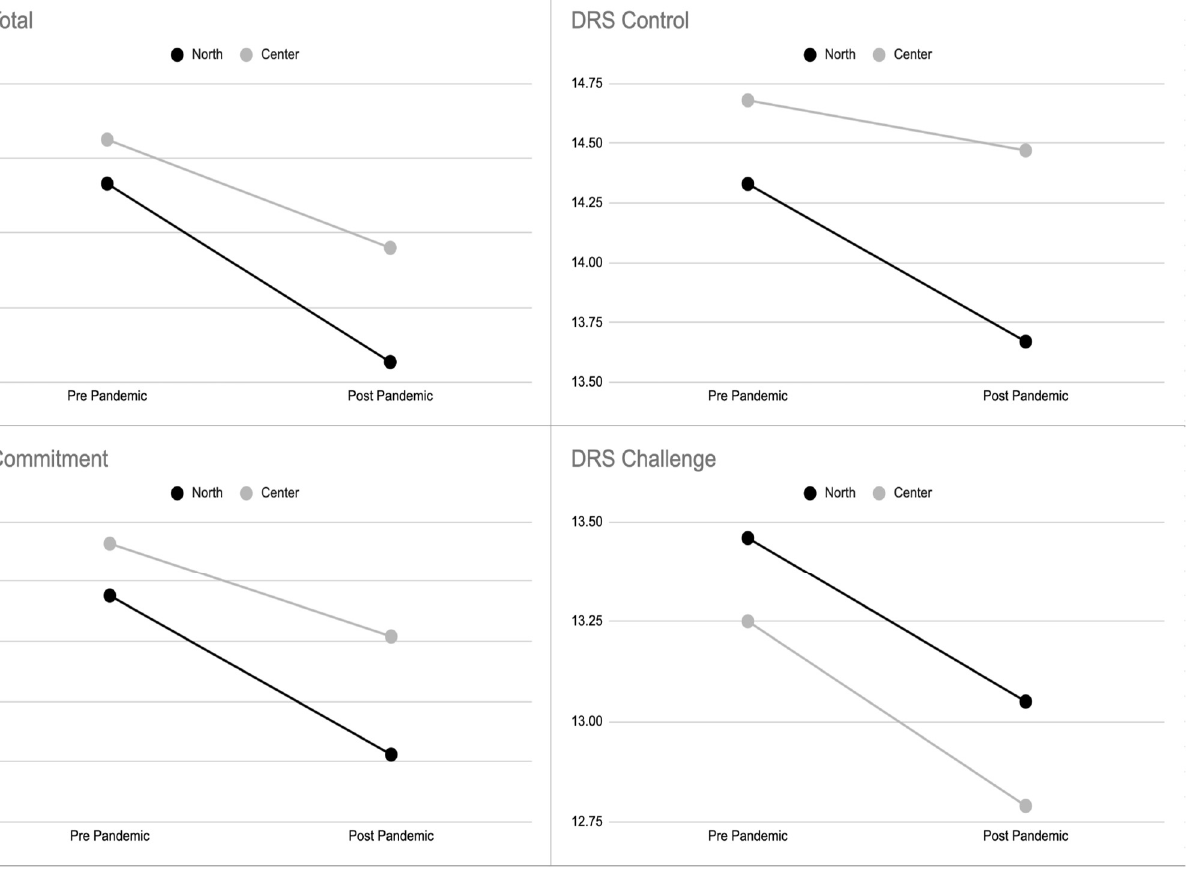
Figure 3. Hardiness levels (total, commitment, control, and challenge) in the two subsamples of nurses from Northern Italy and those from Central Italy.